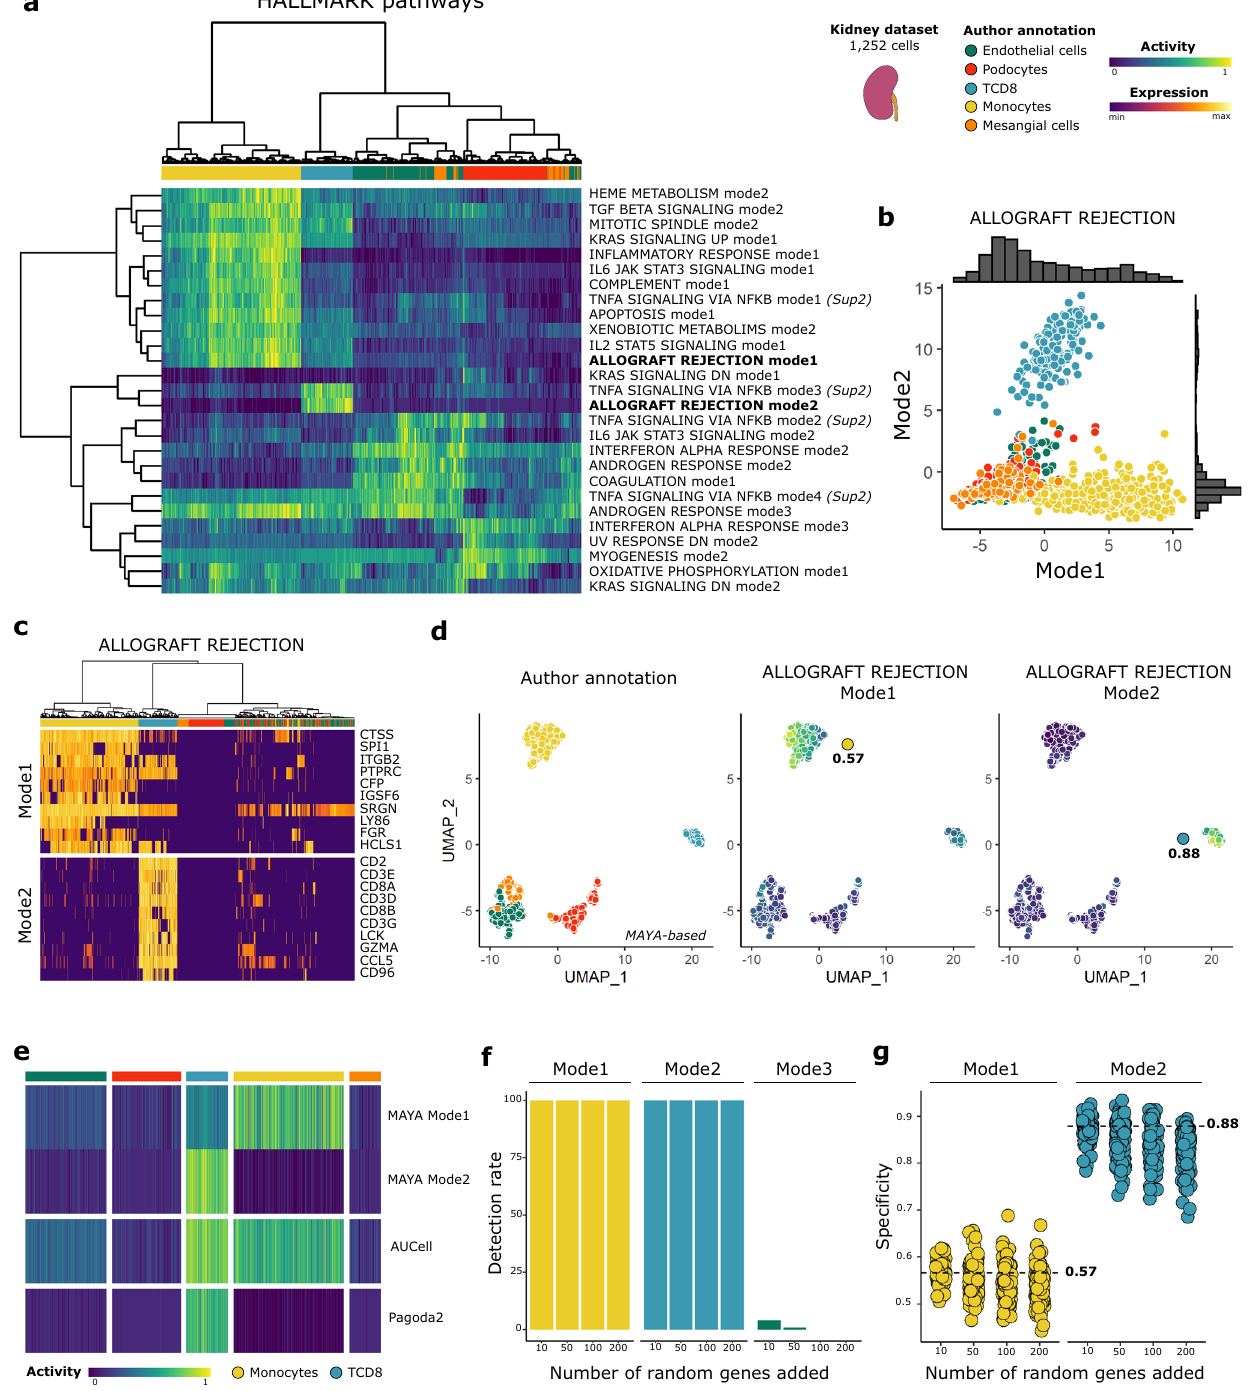
Fig. 2 | Activation modes of Hallmark pathways in kidney with MAYA. a Heatmap of activity matrix computed on kidney dataset with MSigDB Hallmark pathways,initialauthorannotationisindicatedaboveheatmap.Thetwo activation modes of Allograft Rejection are highlighted in bold and further described in the subsequentpanels,andthefourmodesofactivationofTNFAsignalingviaNFKBare further described in Supplementary Fig. 2. b Scatterplot of Mode 2 versus Mode 1 cellactivity scores. Associated density histograms are indicated on the sides ofthe graph. c Heatmap of scaled gene expression for top 10 contributing genes for Mode1 (top) and Mode2 (bottom) of Allograft Rejection pathway, ordered by decreasing contribution for each. d UMAP representation of activity matrix of Hallmark pathways, cells are colored according to author annotation, or activity